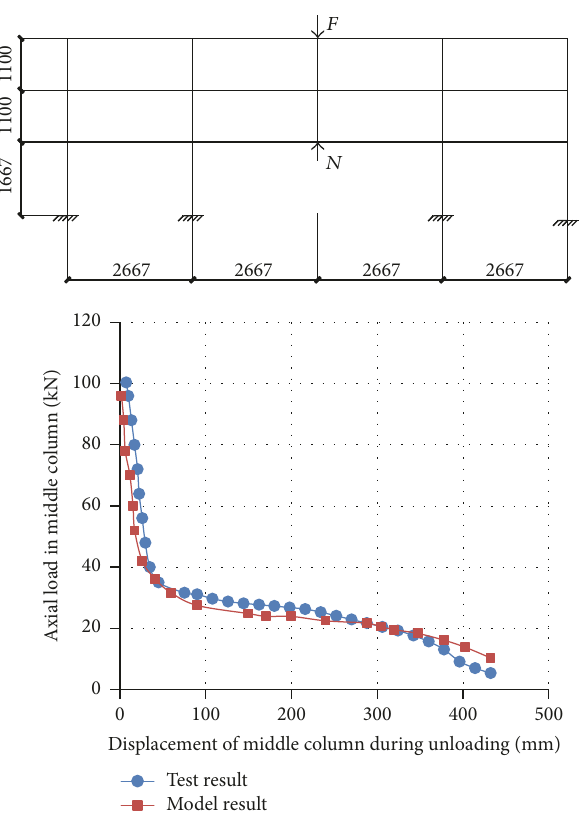
Figure 6: Load-displacement curves of pushdown analysis and test